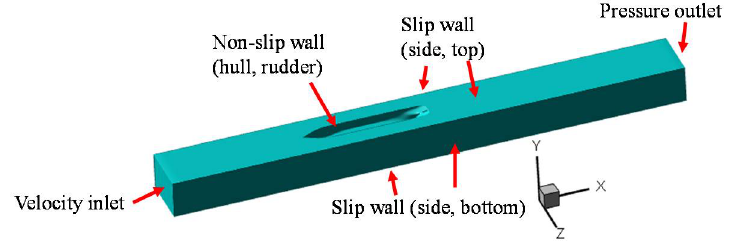
Figure 6. The RANS model in the BEM/RANS scheme.